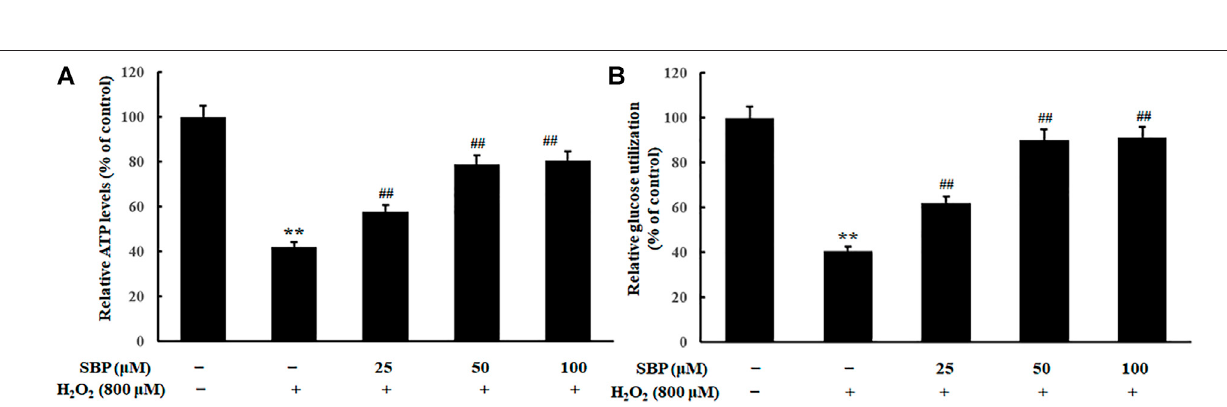
2 O 2 -treatedgroup.